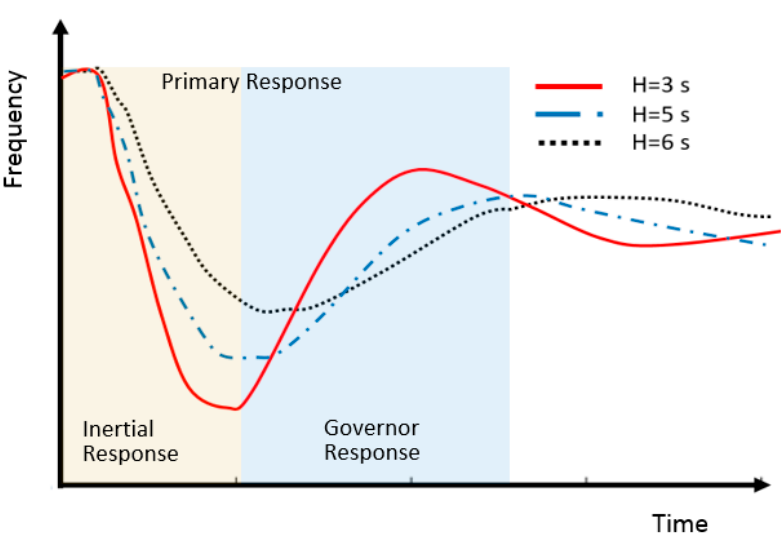
Figure 1. EPS frequency response time frame with different total system inertia.